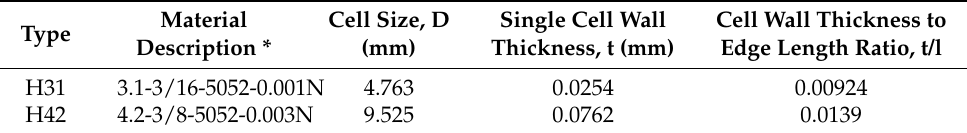
Table 1. Specification of aluminum honeycombs [20].